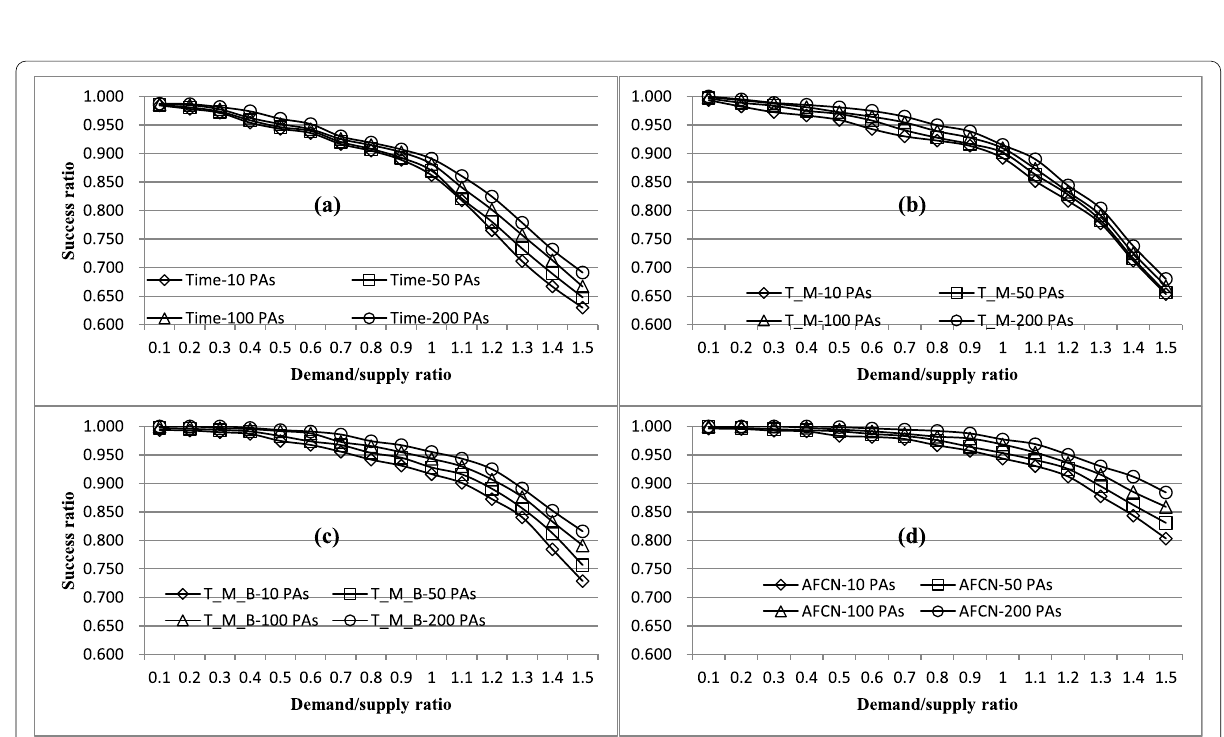
Fig. 14 Success ratio for different numbers of